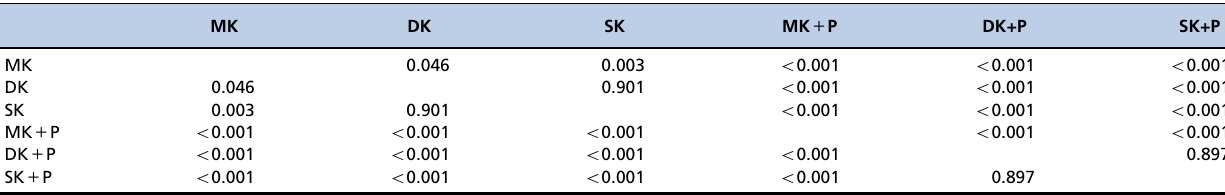
Table 3 - p -values for Ultimate Failure Loads of the six suture